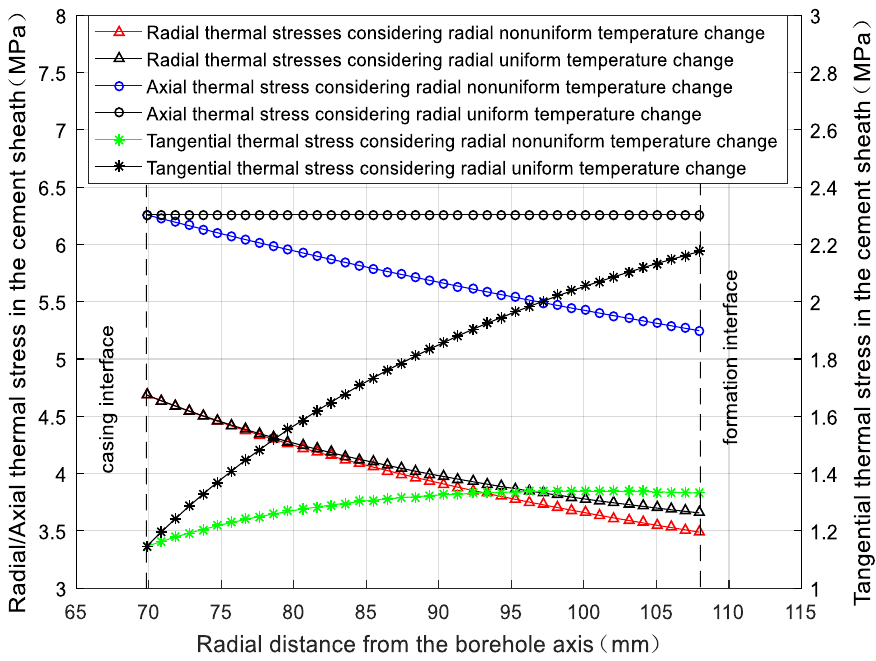
Figure 2 . Radial distribution of radial, tangential, and axial thermal stresses in the cement sheath.